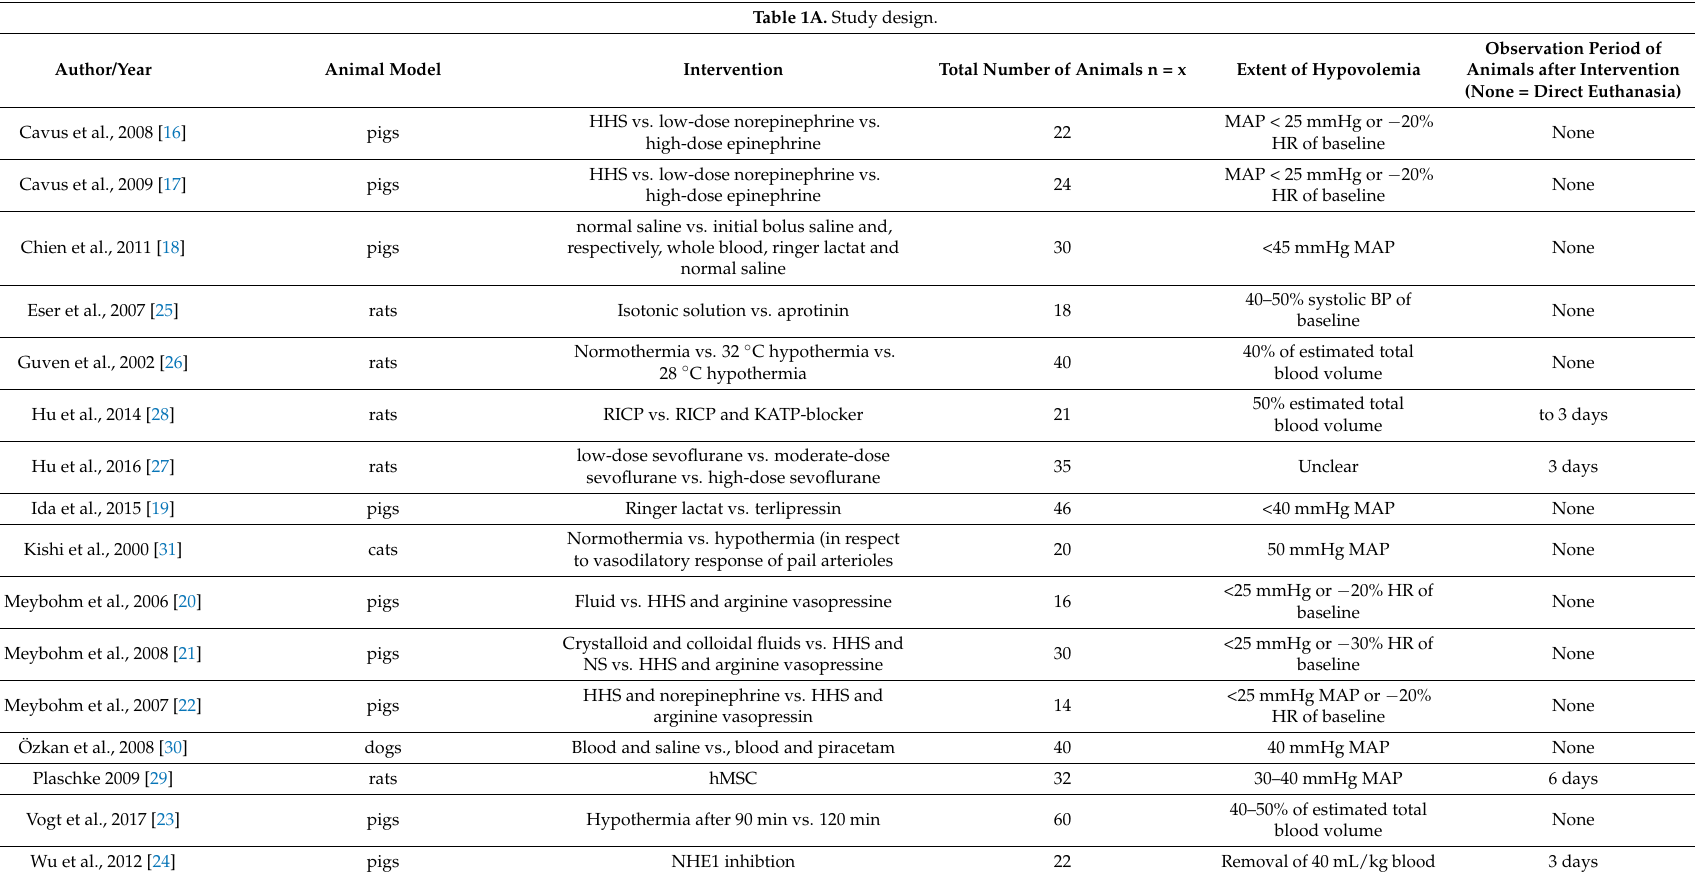
Table 1. A/B. General overview of included studies. Table 1A. Study